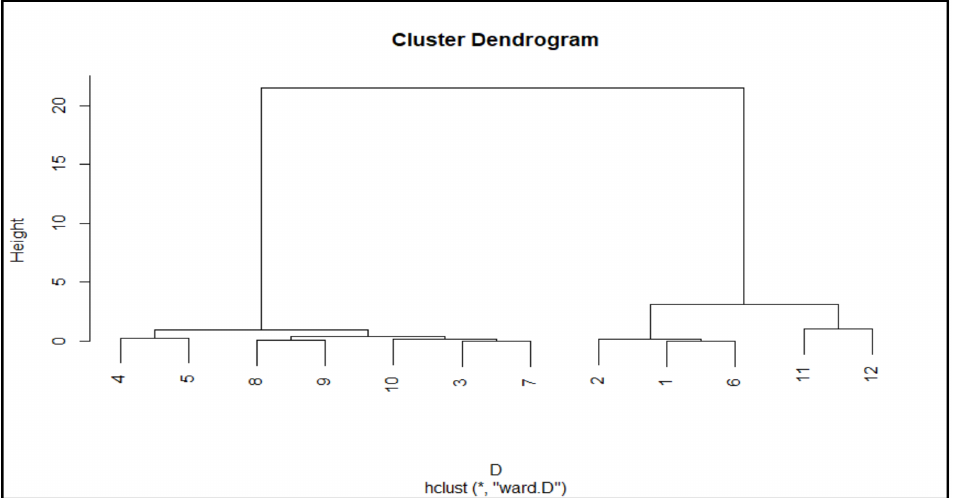
Figure 3. Concept of cluster analysis.